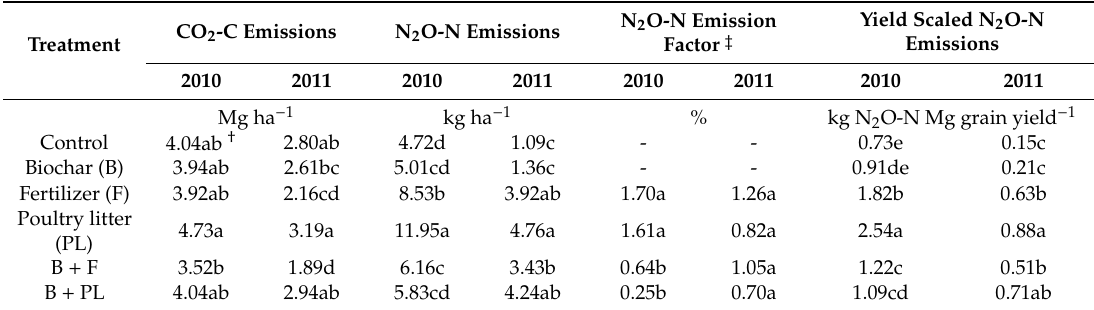
Table 5. Cumulative growing-season CO 2 -C and N 2 O-N emissions, N 2 O-N emission factor, and yield-scaled N 2 O emissions for each treatment in 2010 and 2011.